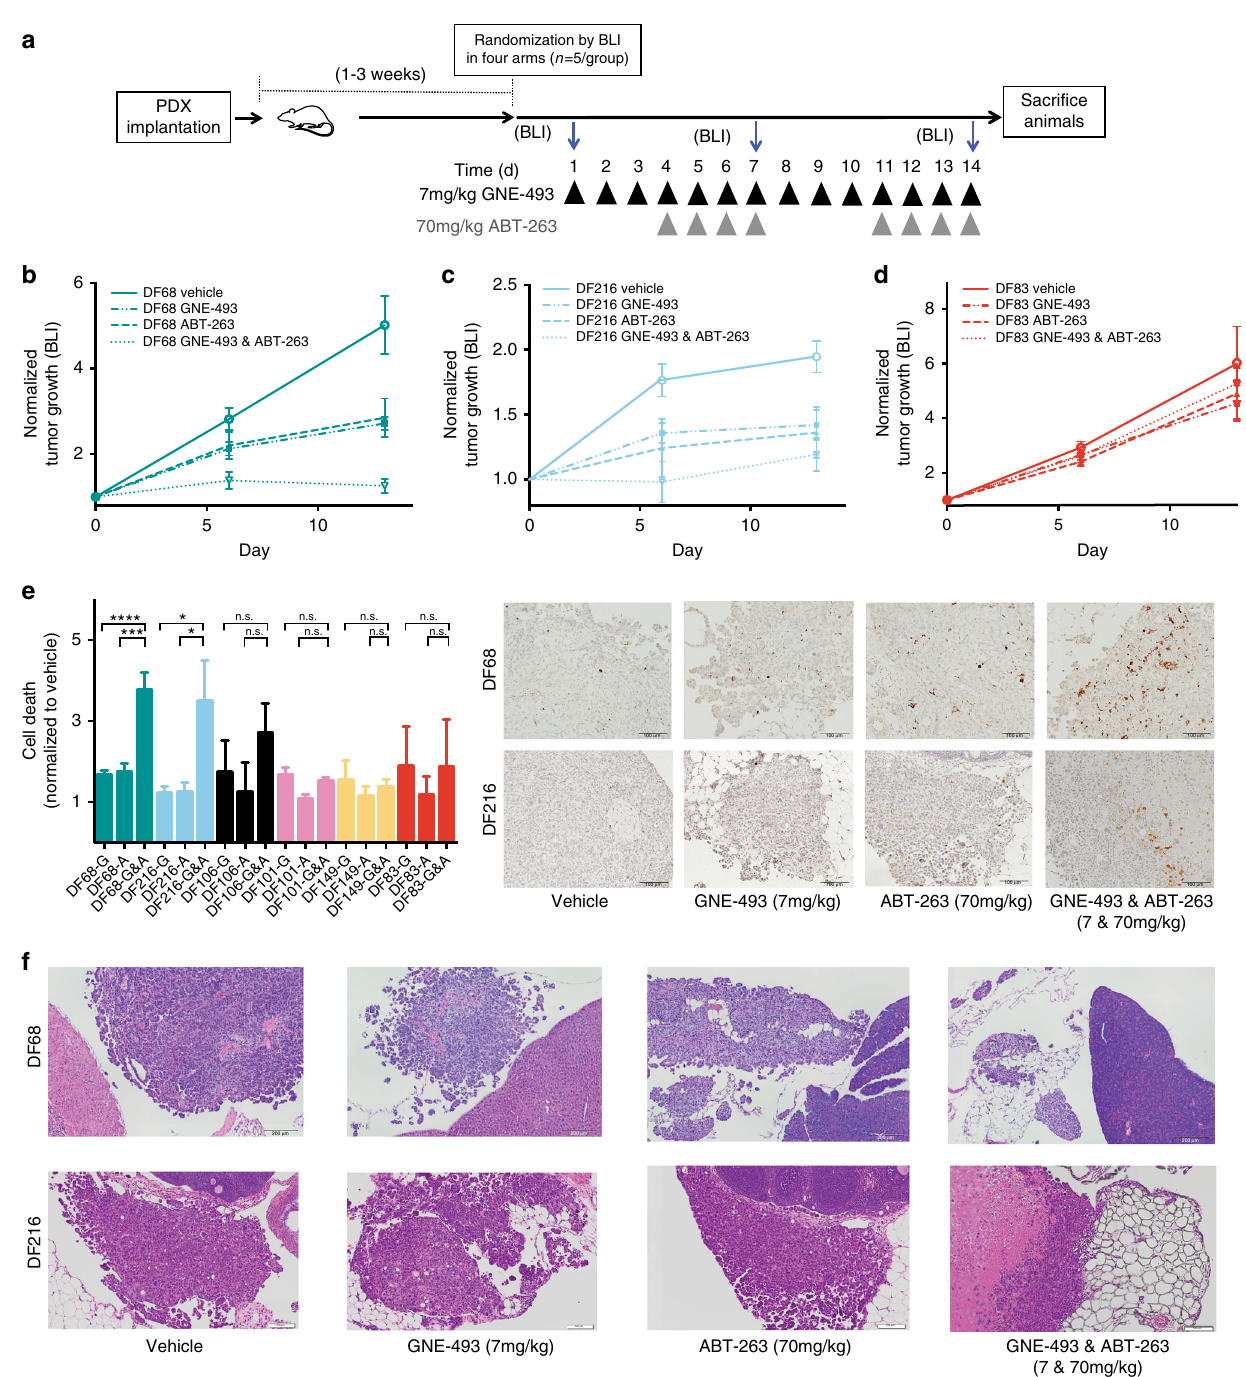
Fig. 4 Combination of PI3K/mTOR and BCL-2/BCL-X L inhibition enhances the activity of single-agent treatment in vivo and increases cell death in a subset of PDX samples. a Combination treatment dosing schedule. b , c , d Tumor growth curve (determined by bioluminescence imaging (BLI)) of three PDX models (DF68, DF216, DF83) that exhibit different sensitivities to the PI3K/mTOR (7 mg kg − 1 GNE-493) and BCL-2/BCL-X L (70 mg kg − 1 ABT-263) drug combination. n = 5 per treatment arm. Error bars represent SEM. e Quanti fi cation of tumor cell death by cleaved-caspase 3 (cc3) immunohistochemistry (IHC) and representative cc3 images in tumors (scale bar 100 μ m). Error bars represent SEM across n = 30 locations from three independent animals (Kruskal – Wallis test: * p < 0.05, ** p < 0.01, *** p < 0.001, **** p < 10 − 4 ). f Representative histological images of solid tumor implants in the abdominal cavity in two responsive PDX samples (DF68 and DF216). Scale bar 200 μ the PI3K- β isoform-sparing PI3K inhibitor tasesilib (GDC-0032), models was similar between the selective inhibitors and the dual the pan-PI3K inhibitor pictilisib (GDC-0941), and the mTORC1/ PI3K/mTOR inhibitor (Fig. 3e and Supplementary Fig. 4). PDX 2 inhibitor sapanisertib (INK-128) in PDX models with a range of models with medium phospho-AKT, but high phospho-4EBP1 GNE-493 sensitivities. First, we examined the effects of these protein levels (DF216, DF118, DF14, Fig. 3e) were sensitive to inhibitors as single-agents. Overall, the ranking of the PDX mTOR inhibition either by INK-128 or GNE-493 and responded